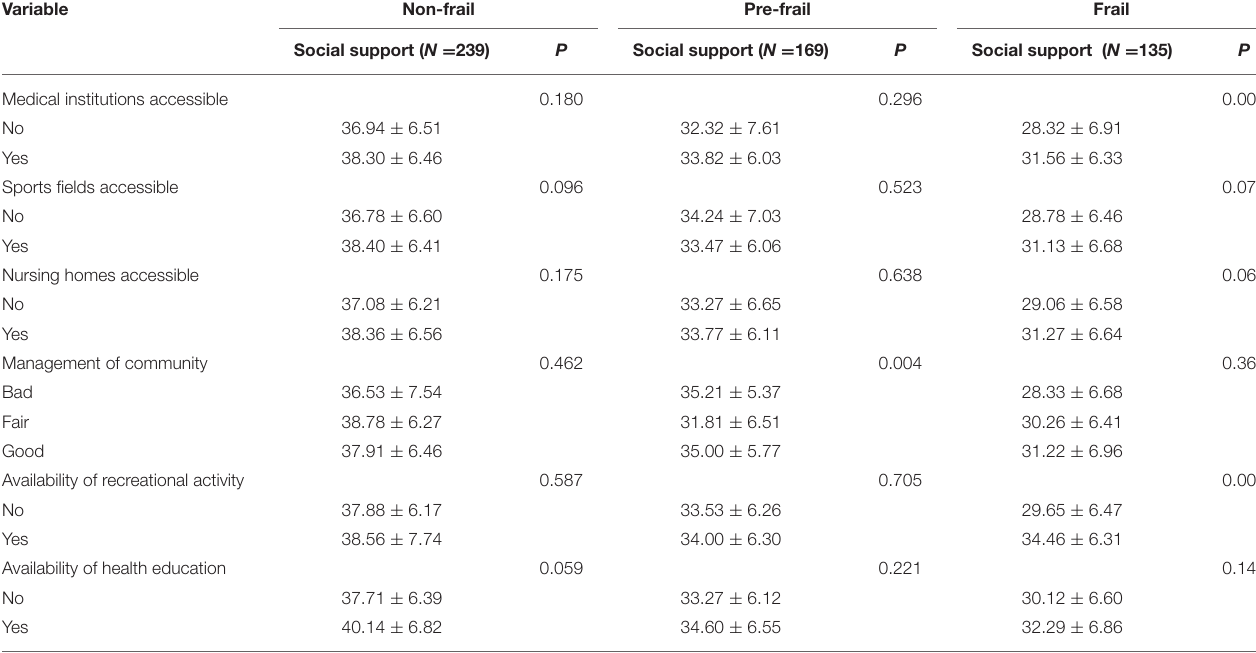
TABLE 5 | The impact of community environment on social support according to the frailty category. Variable